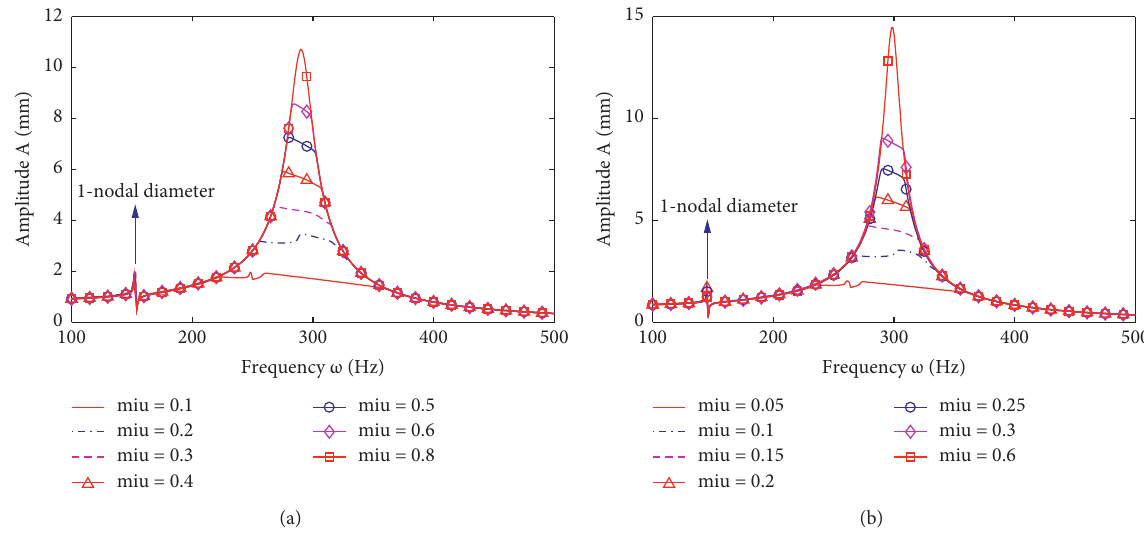
Figure 18: The amplitude-frequency response curves of beam 1 for different friction coefficients: (a) Ω � 200rad/s and (b) Ω �